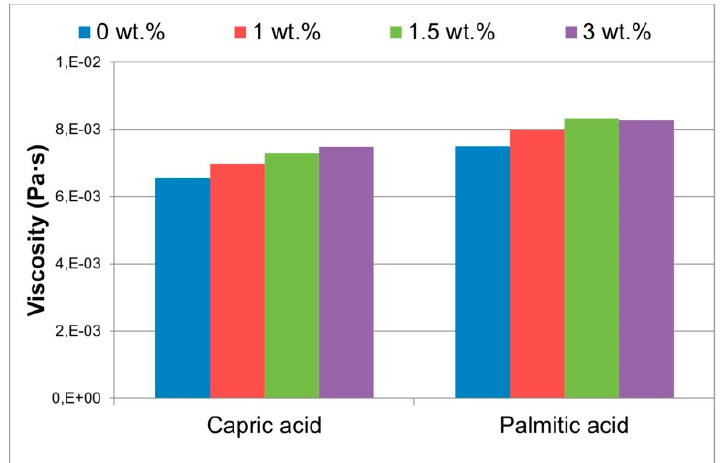
Figure 17. Effect of nanoparticle mass fraction on viscosity of the capric acid and palmitic acid NEPCM [50].